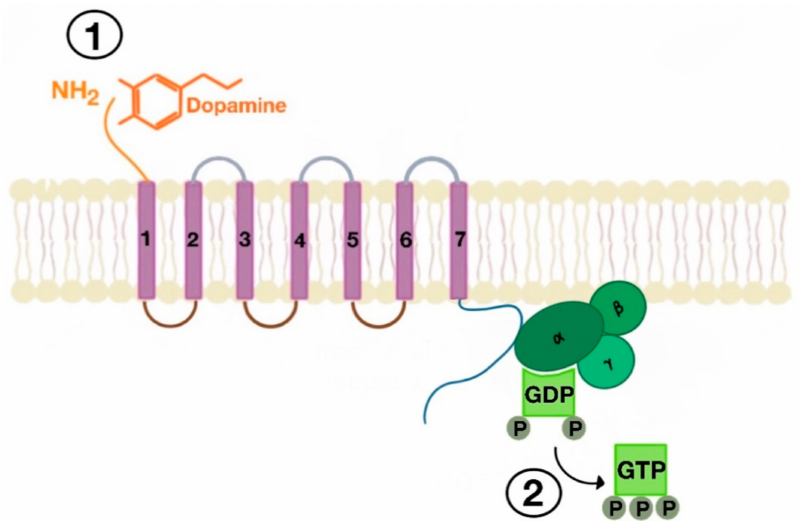
Figure 3. Agonist-induced stimulation of G protein-coupled receptors (GPCRs) (e.g., dopamine receptor (1) and phosphorylation of GDP to GTP on the G α subunit of the G protein (2)).